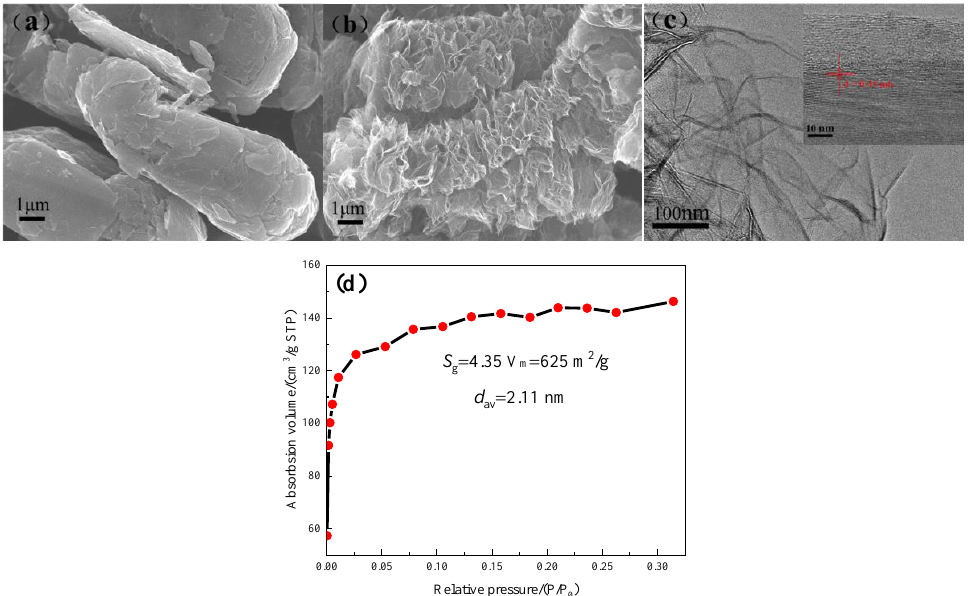
Figure 2. ( a ) SEM of SG powder; ( b ) SEM of GR powder; ( c ) TEM of GR powder; ( d ) N 2 adsorption-desorption isotherm of GR powder.